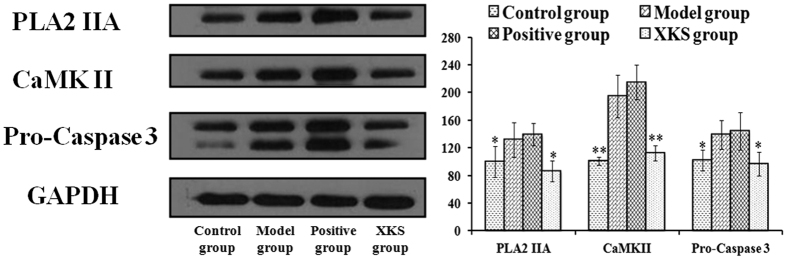
(A) XKS effect on PLA2 IIA, CaMK II and Pro-Caspase-3 in myocardium sample of the tested rats. (B) Bar graphs represent mean ± SD. of the expressions of PLA2 IIA, CaMK II and Pro-Caspase-3 in myocardium samples of the tested rats. aValues are significant difference compared with control group, p < 0.05. bValues are significant difference compared with control group, p < 0.01. cValues are significant difference compared with model group, p < 0.05; dValues are significant difference compared with model group, p < 0.01.